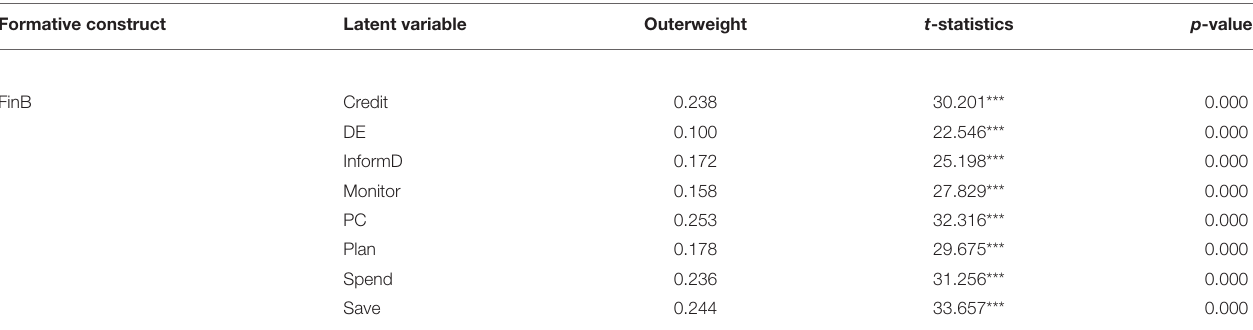
TABLE 5 | Significance and relevance of formative construct FinB.